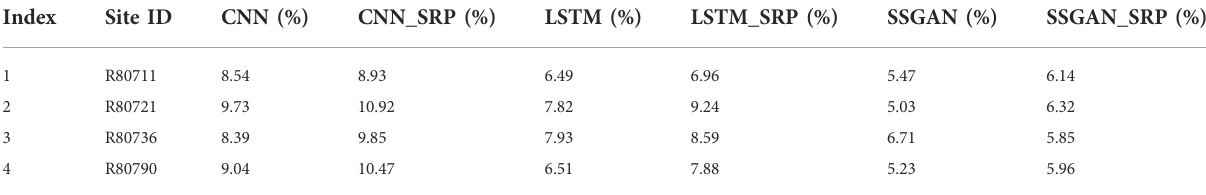
TABLE 5 MAPE results of short-term wind power forecasting on